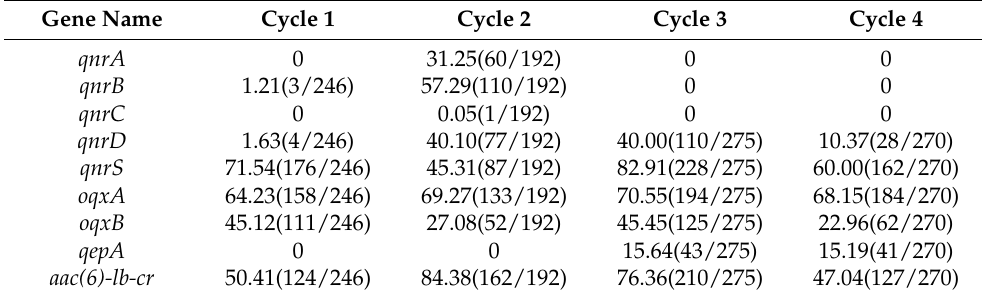
Table 5. Detection rate of drug resistance genes in different cycles of E. coli (unit: